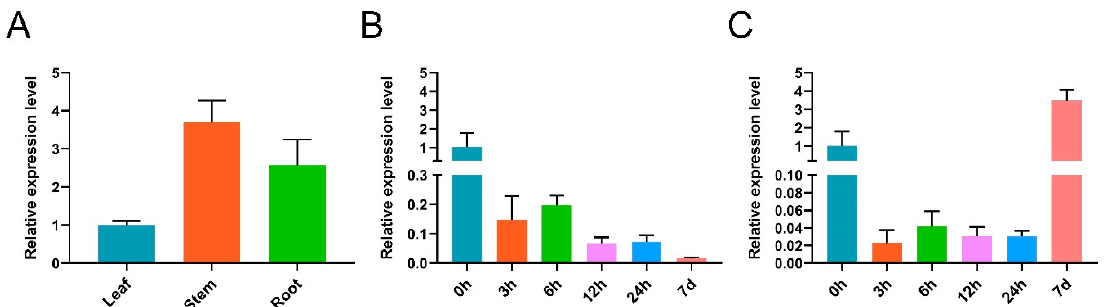
Figure 9. Expression analysis of AnAO5 gene using qRT-PCR analysis. ( A ) Expression of AnAO5 gene in leaves, stems, and roots of A. nanus . ( B ) Expression patterns of AnAO5 gene under osmotic stress. ( C ) Expression patterns of AnAO5 gene under cold stress. A. nanus eIF1 was used as the in- ternal control. Each experiment was performed in three independent biological replicates, and the error bar showed SD ( n = 3).